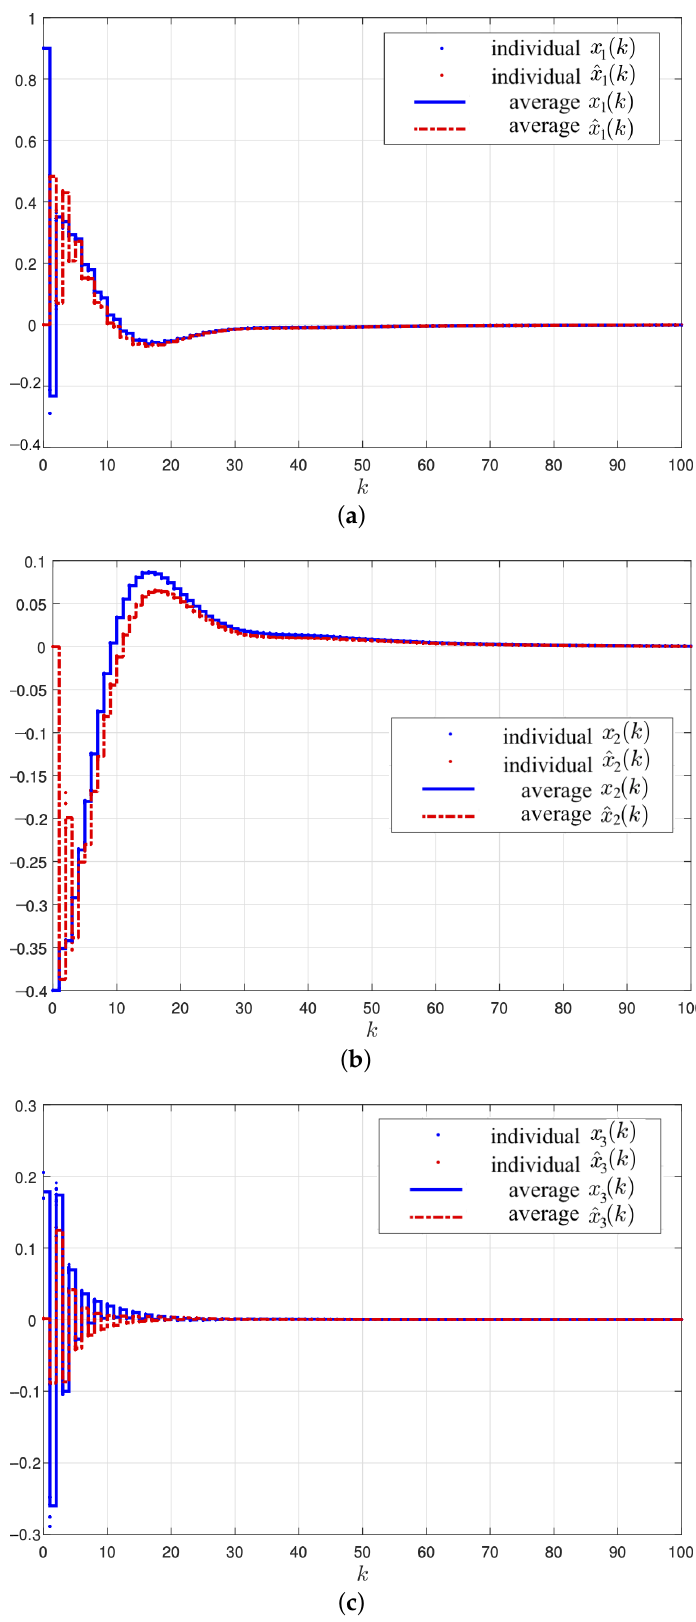
Figure 2. Trajectories of x 1 ( k ) and ˆ x 1 ( k ) ( a ), x 2 ( k ) and ˆ x 2 ( k ) ( b ), and x 3 ( k ) and ˆ x 3 ( k ) ( c